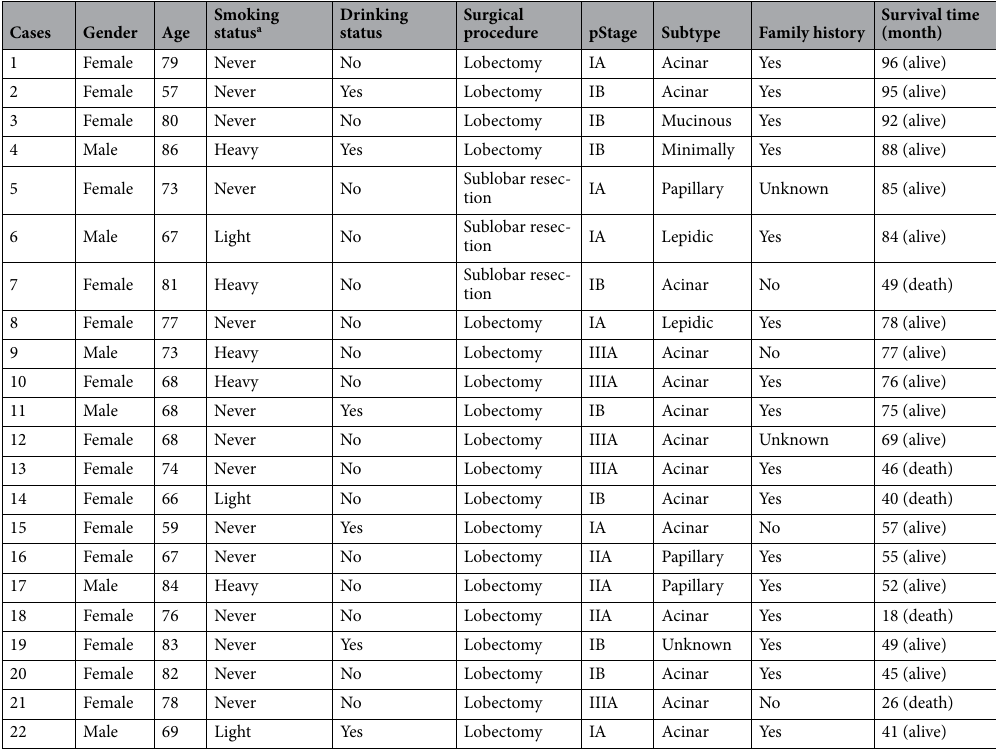
Table 6. Characteristics of all patients (n = 22) of lung adenocarcinoma with CYP2A6 whole-gene deletion. a Smoking status; Light smokers (0 < to < 20), Heavy smokers (> 20), as shown in Table